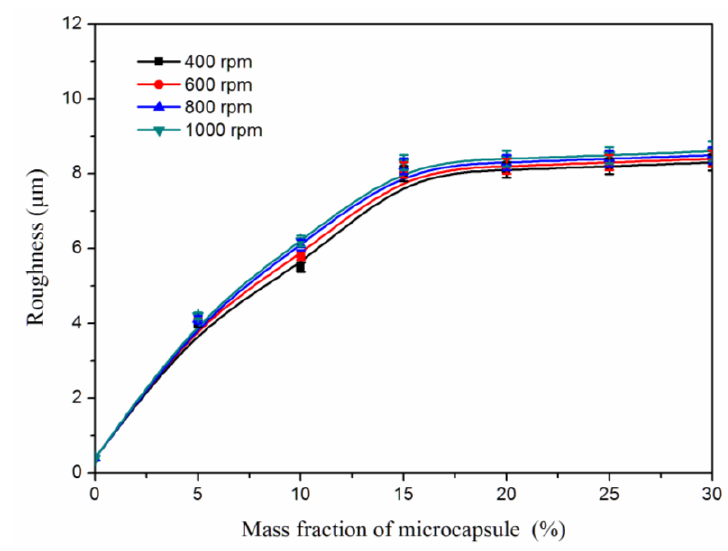
Figure 9. Effect of the mass fractions of microcapsules with different stirring rates on the gloss of water-based paint film.